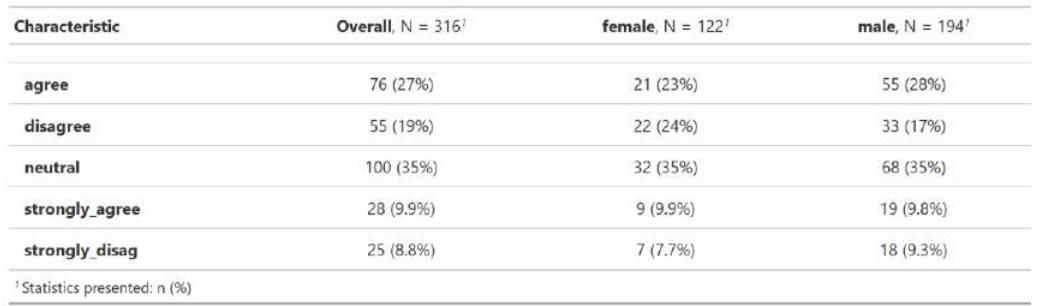
Table 34: Do you think a peace deal with the Taliban will negatively affect India-Afghan relations? (Source: Authors‟